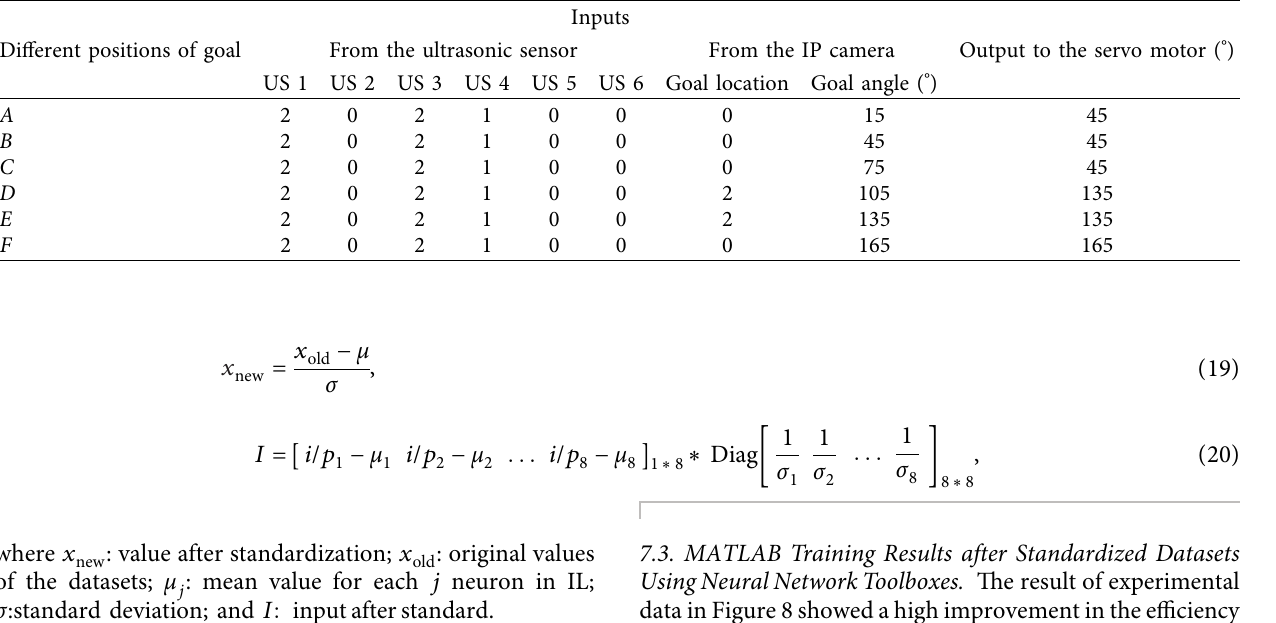
Figure 4: Example of case studies and their output according to the previous one. O : the position of obstacles in all states. A , B , C , D , E , F : the different positions of the Table 7: Situations on the real environment.